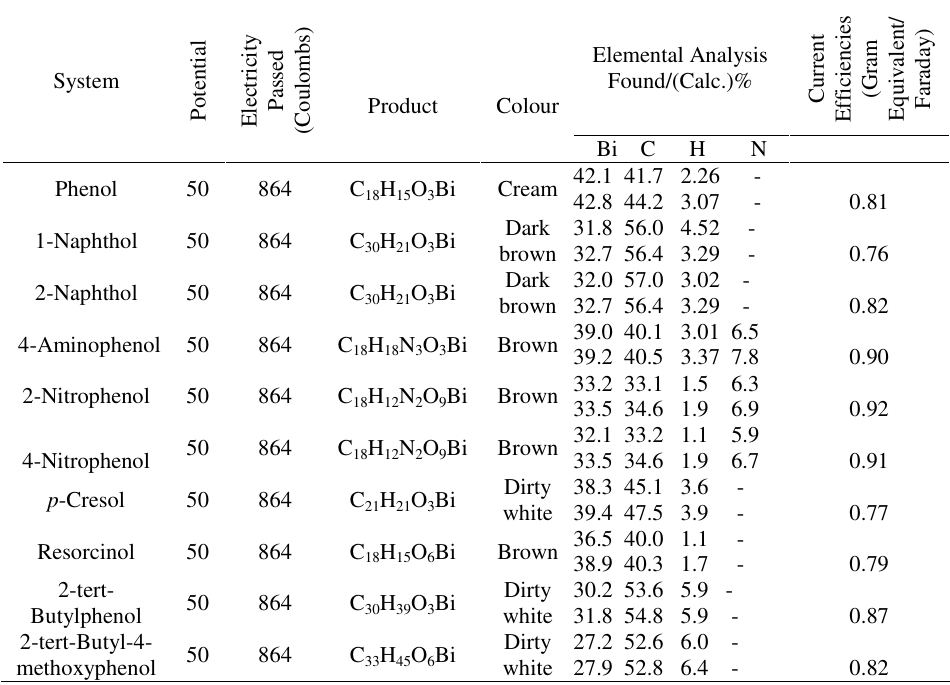
Table 1. Electrolysis characteristics, analytical and other related data of electrolysis of phenols at bismuth anode